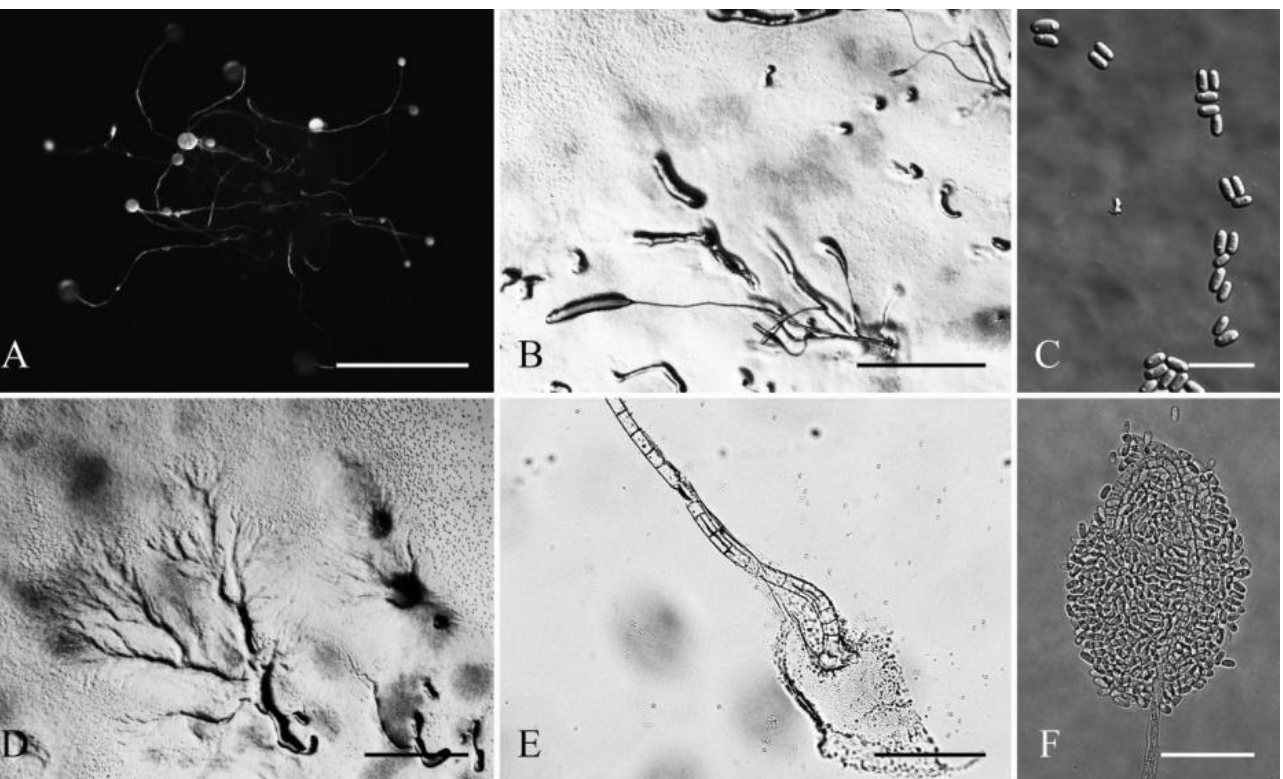
Figure 7. Morphological features of Cavenderia ungulata (TH18B). ( A ), Sorocarps. ( B ), Clustered pseudoplasmodia. ( C ), Spores. ( D ), Aggregations. ( E ), Sorophore base. ( F ), Sorophore tip. Bars: ( A , B ) = 1 mm; ( C ) = 20 μ m; ( D ) = 1 mm; ( E ) = 60 μ m; ( F ) = 40 μ m.